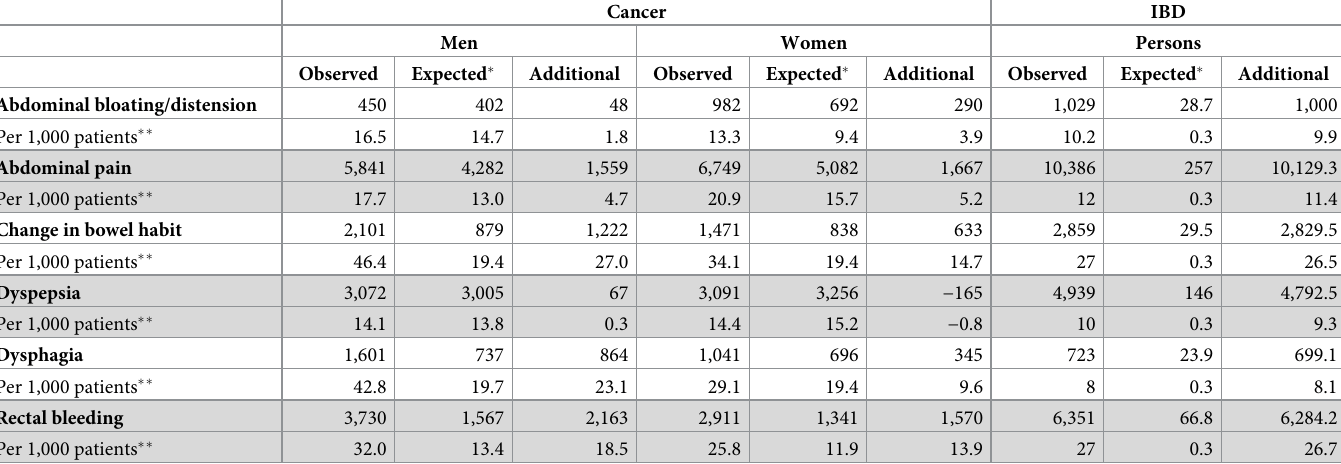
Table 4. Illustration of additional cases of cancer and IBD following presentation with each studied symptom above what would be expected by the 12-month gen- eral population incidence of either condition, as applied to the age and sex composition of our study